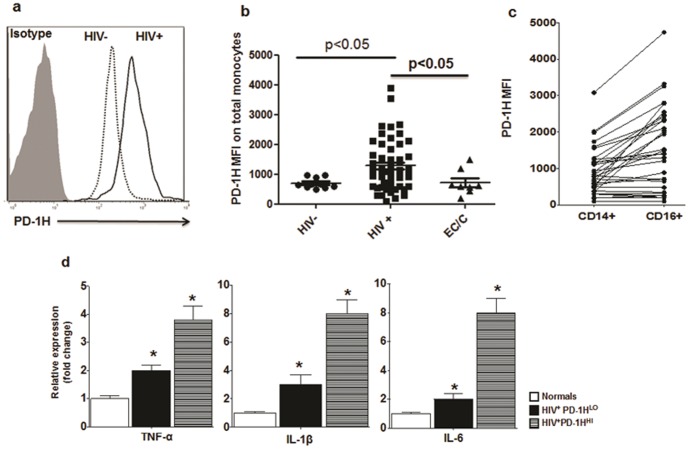
Overexpression of PD-1H on monocytes in HIV infection.A representative histogram (a) and cumulative data (b) of PD-1H expression on CD14 gated PBMC from normal and HIV-infected donors. MFI, mean fluorescence intensity. EC, elite controllers. C, controllers. * indicates p<0.05, Kruskal Wallis test followed by Dunn multiple comparison tests. c) PD-1H expression on CD14+ (classic) and CD16+ (activated) monocytes from HIV+ donors. Each horizontal line represents expression on CD14+ and CD16+ monocytes from the same individual. d) The mRNA expression level for indicated cytokines in ex vivo-isolated monocytes from normal and HIV-infected individuals was assessed by real time PCR. Mean + SD from PBMCs from five donors. (PD-1HHI MFI: 1600-4500; PD-1HLO MFI 700-1500). *  =  p<0.05 (One way ANOVA followed by Tukey test).